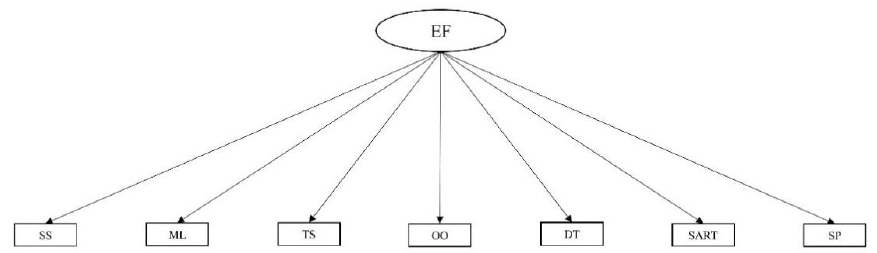
Figure A1. Graphical representation of the model by Laureys et al. (in press). SS = Spatial Span, ML = Monkey Ladder, TS = Token Search, OO = Odd One Out, DT = Double Trouble, SART = Sustained Attention to Response, SP = Spatial Planning.